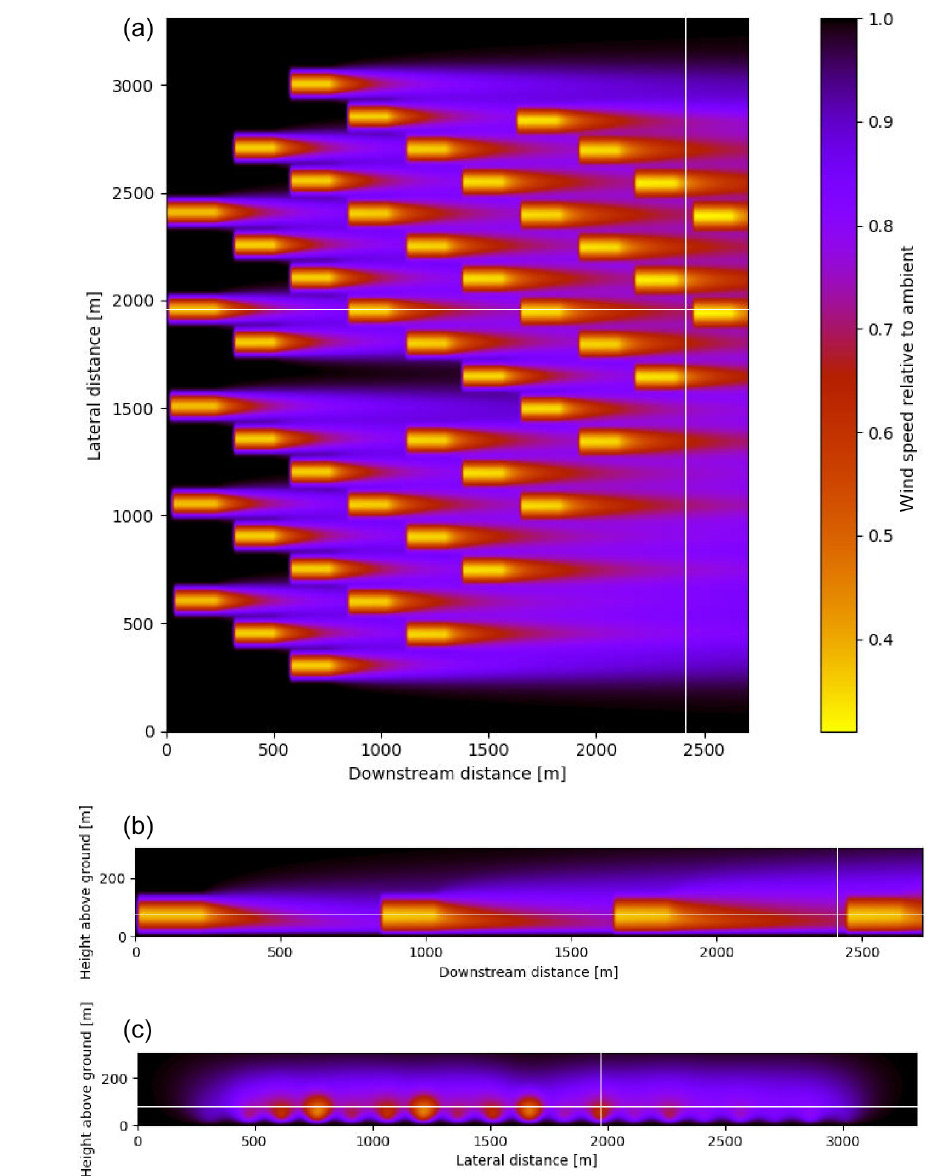
Figure 4. Plots of the axial velocity on the wind farm relative to ambient wind speed for a flow case of 8ms − 1 with the wind from the west. From top to bottom, (a) x – y (bird’s-eye) slice at hub height, (b) x – z (side-on), and (c) y – z (front-on). The white lines show the corresponding planes of the other plots. The x – y plot is taken at the turbine hub height above sea level – 68m.